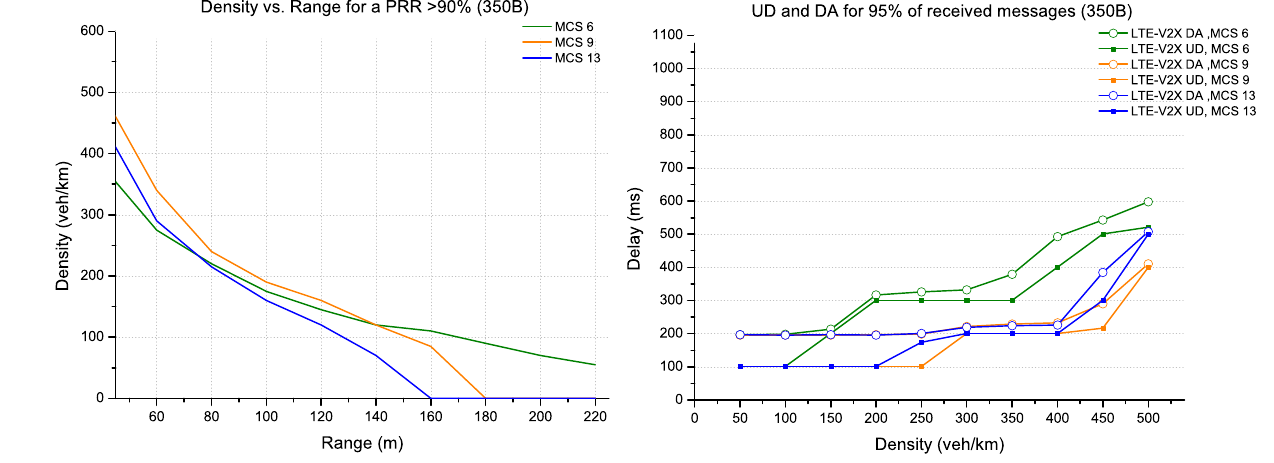
Figure 8. Evaluation for LTE-V2X technology (packet size 350 bytes). In Figure 9, the packet size has increased to 800 bytes. The possible configurations for this TB size are provided by the MCS 9 and MCS 13 coding that respect the recommended coding rate. The MCS 9 coding has the highest range for all density scenarios. On the other hand, there is a slight delay in performance with MCS 13 on densities below 350 veh/km.